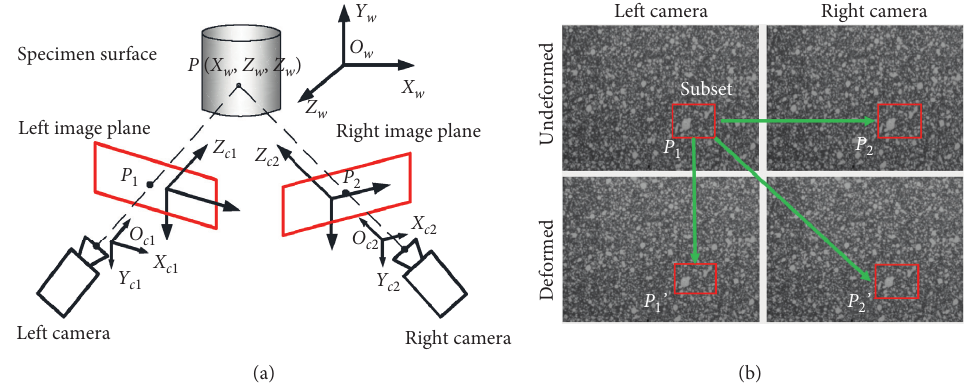
Figure 1: 3D-DIC measurement principle. (a) Binocular stereo vision principle. (b) Three-dimensional displacement